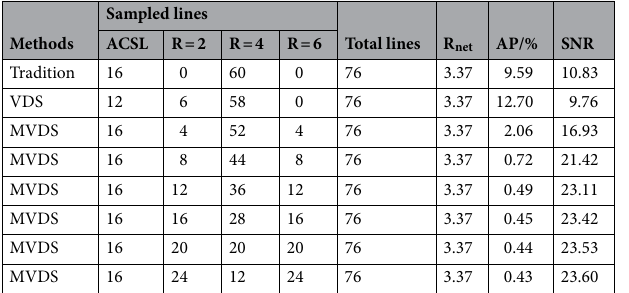
Table 1. The comparison of reconstruction images sampled using traditional method, VDS method, and MVDS method.